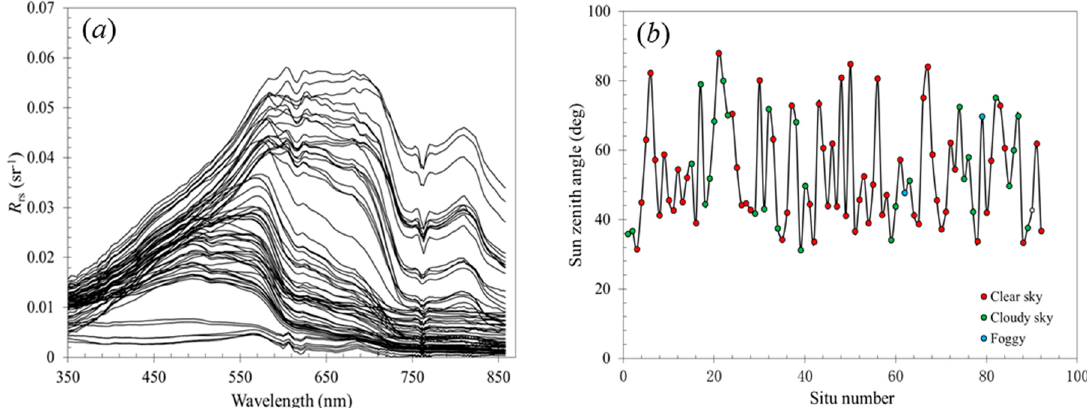
Figure 2. ( a ) Typical spectra of remote-sensing reflectance collected in the Changjiang estuarine and its adjacent coastal waters; ( b ) The sun zenith angle and weather conditions of in situ R rs ( λ ) validation data.